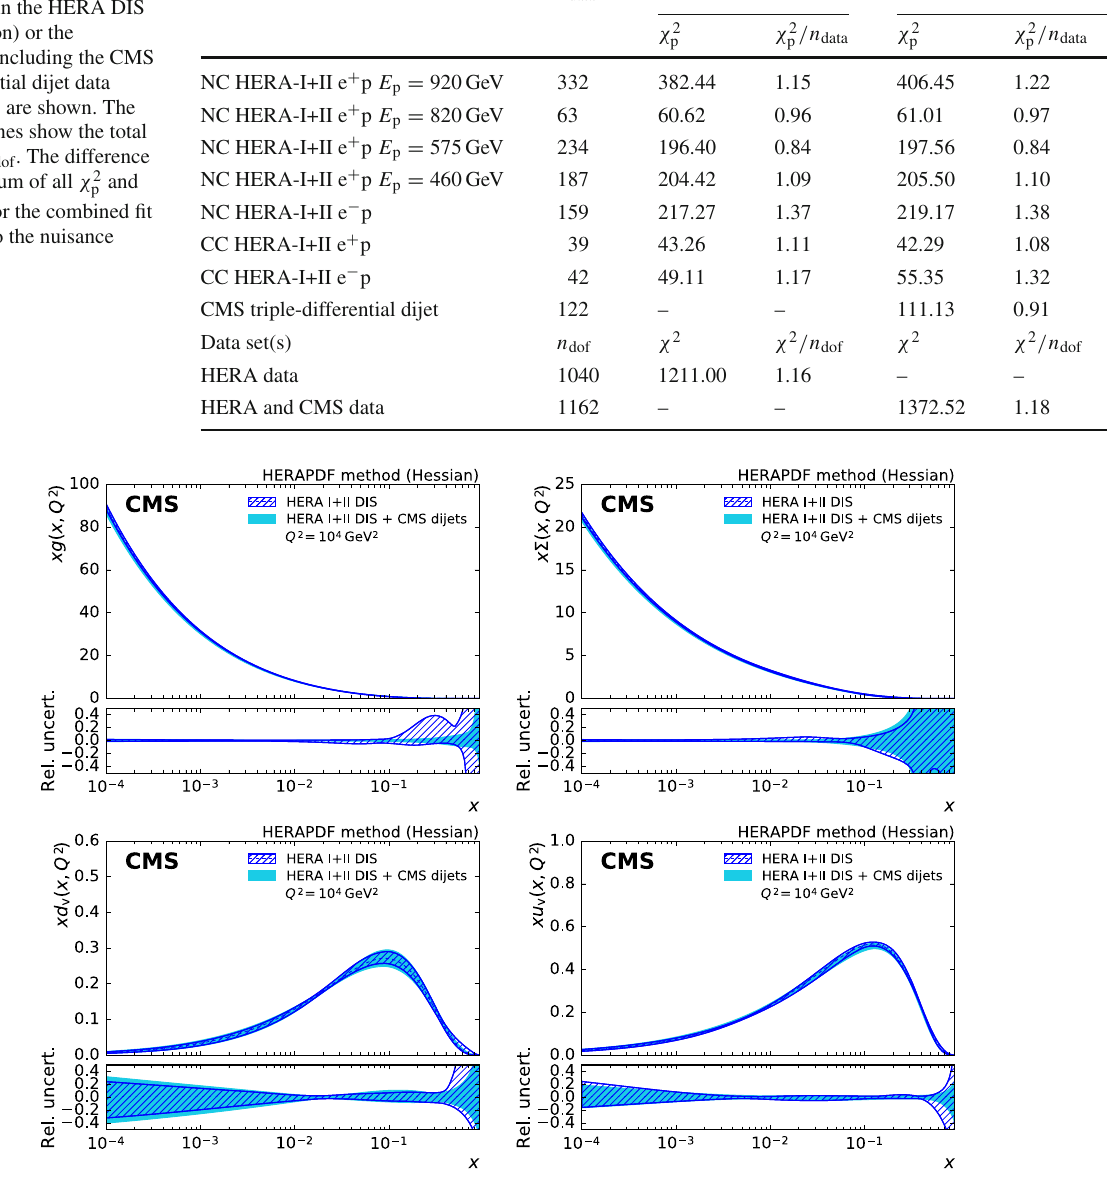
combination with CMS dijet data (solid band). The PDFs are shown at the scale Q 2 = 10 4 GeV 2 with their total uncertainties